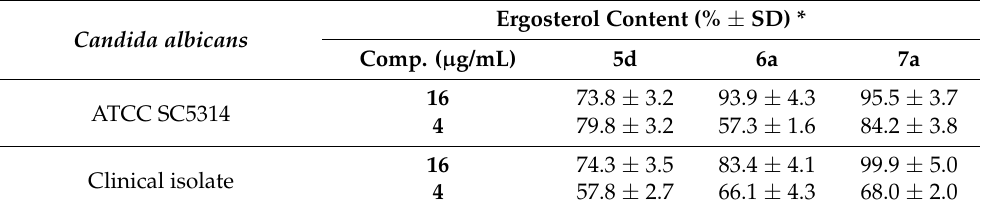
Table 5. UV spectrometric ergosterol content (%) in the benzoxazole-treated C. albicans . Ergosterol Content (% ± SD) * Candida albicans